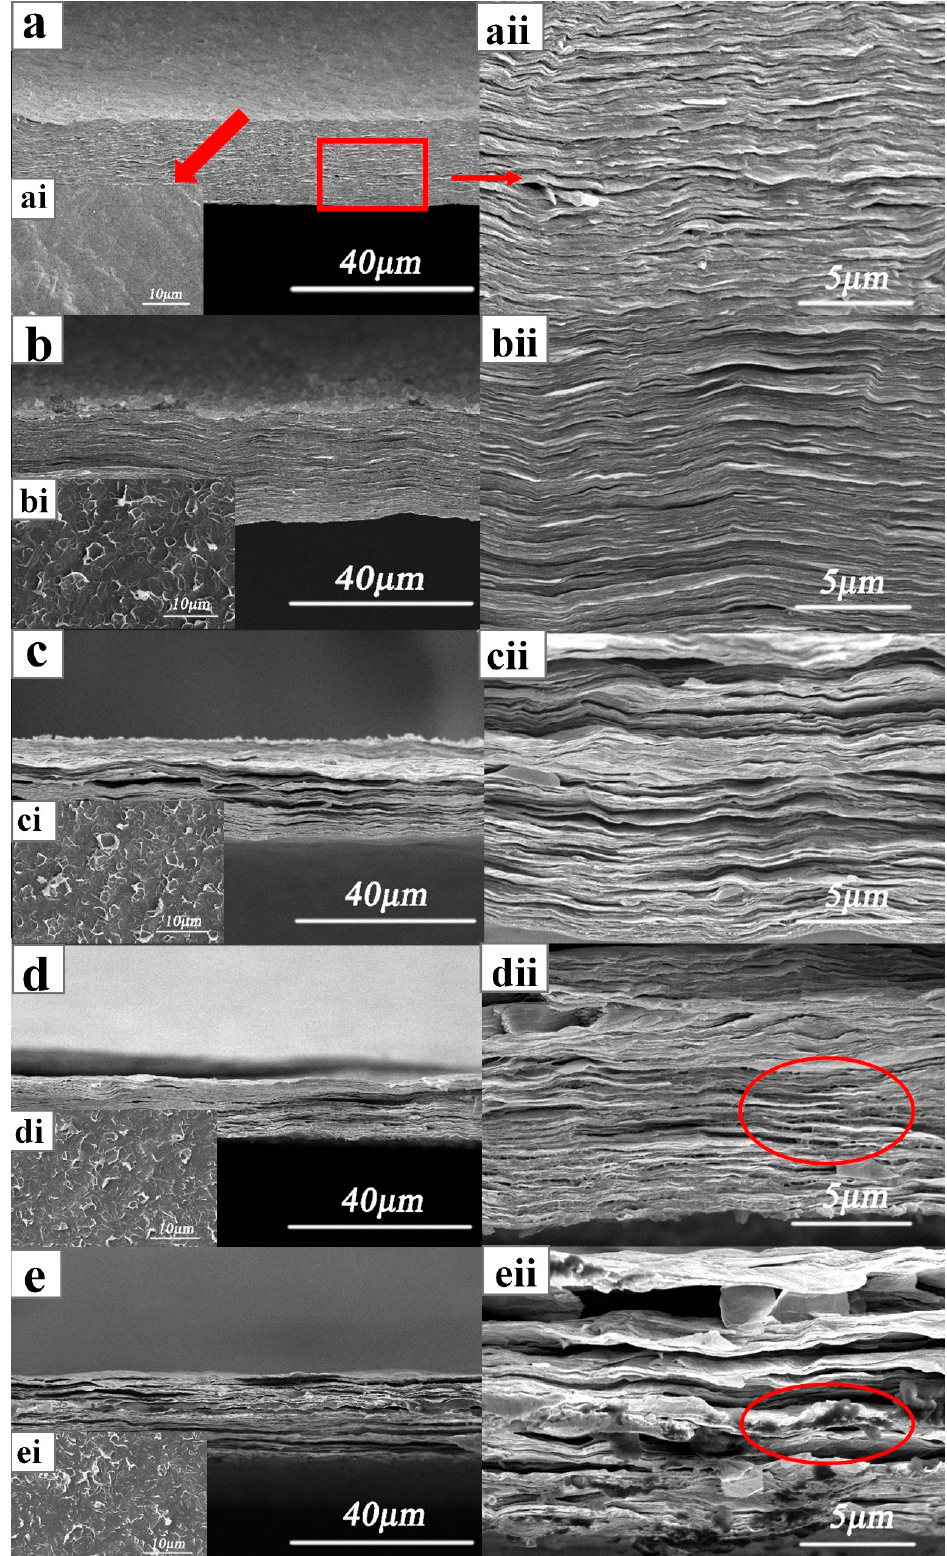
Figure 2. Cross-sectional and surface SEM images of composite films (( a – e ) are images of the cross sections of NCC/rGO, NCC/rGO/PEG-(1–4), respectively; ( ai – ei ) are surface images of the samples; and ( aii – eii ) are enlarged cross-sectional